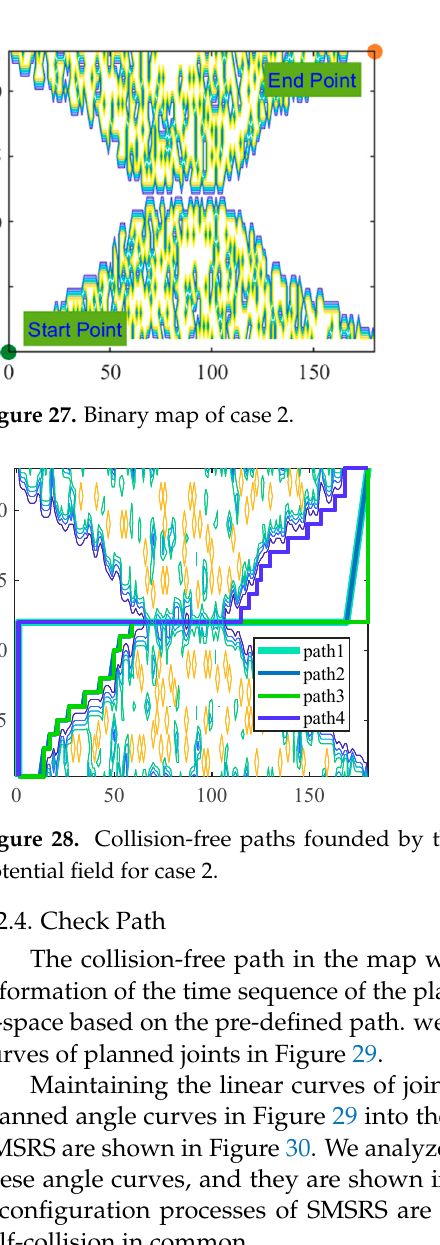
Figure 29. Angle curves of planned joints under four collision-free paths. Maintaining the linear curves of joints when no self-collision occurs and inserting planned angle curves in Figure 29 into them, complete curves of all motion joints of the SMSRS are shown in Figure 30. We analyze the reconfiguration processes of SMSRS under these angle curves, and they are shown in Figure 31. Under different angle curves, the reconfiguration processes of SMSRS are different, but they can successfully avoid the self- collision in common.